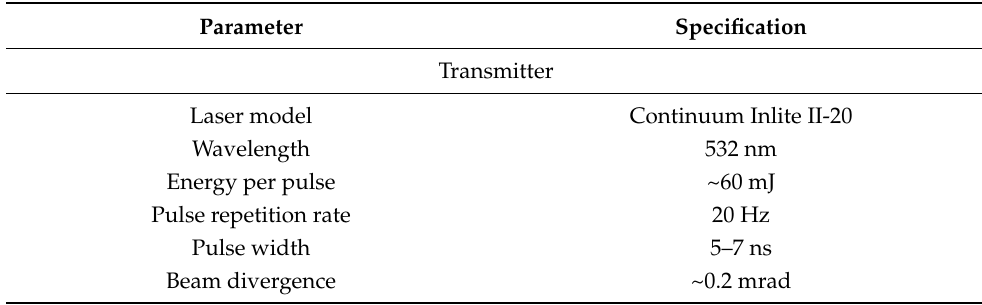
Table 1. Specifications of the polarization lidar at our observation site (30.5 ◦ N, 114.4 ◦ E) in Wuhan,